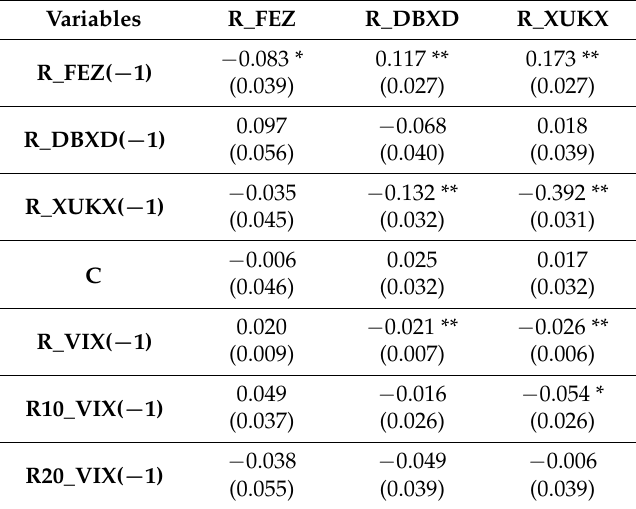
Table 4. Europe Market ETF and VIX